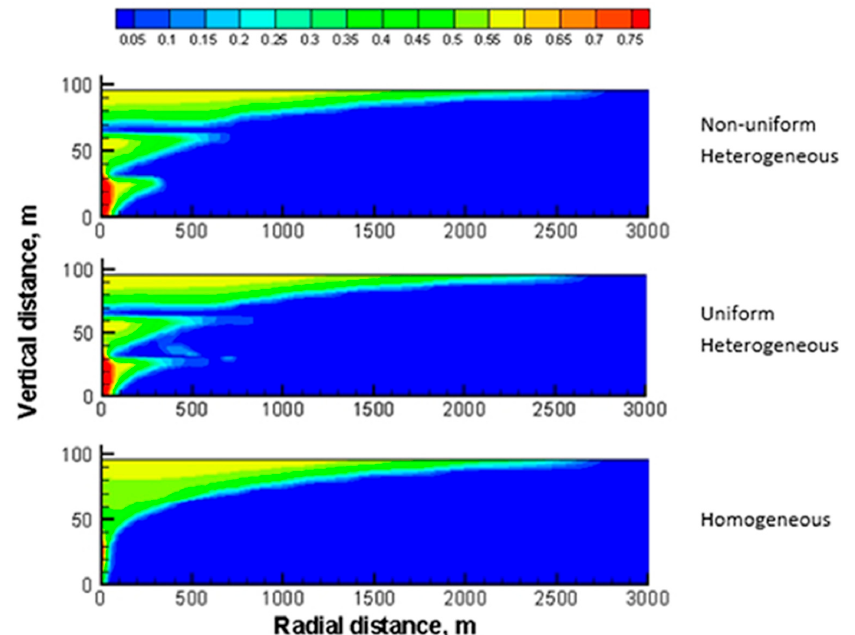
Figure 4. Spatial distribution of CO 2 after 30 years of simulation (end of injection) for homogeneous media (case 1) and heterogeneous media (cases 2 and 3) in Table 3.